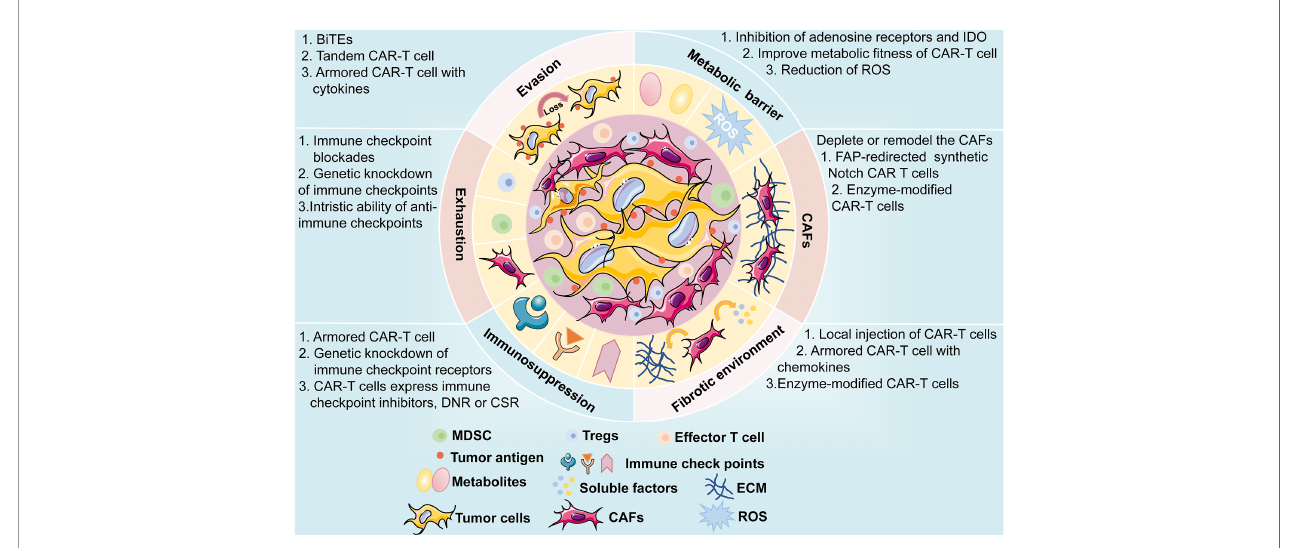
FIGURE 7 | A brief overview of potential challenges faced by CAR-T cell therapy, including antigen evasion, metabolic barrier, CAFs, fi brotic environment, immunosuppression of TME, and exhaustion of CAR-T cells. The possible mechanisms and engineering strategies are also